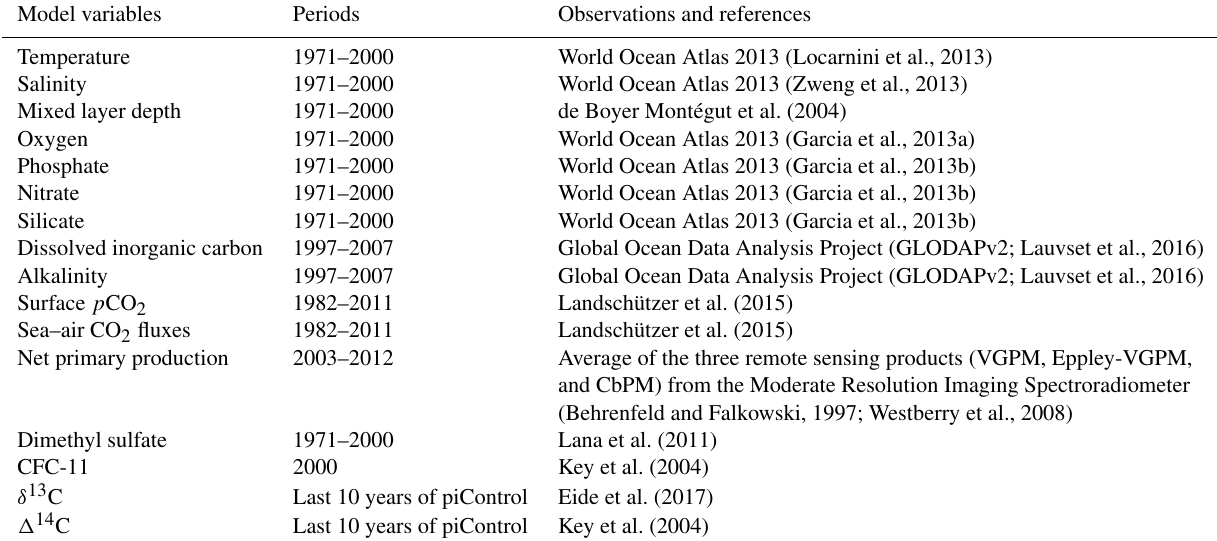
Table 2. List of the simulated variables and the respective historical simulation periods over which their climatological values have been averaged. The last column indicates the observational reference used to validate the model